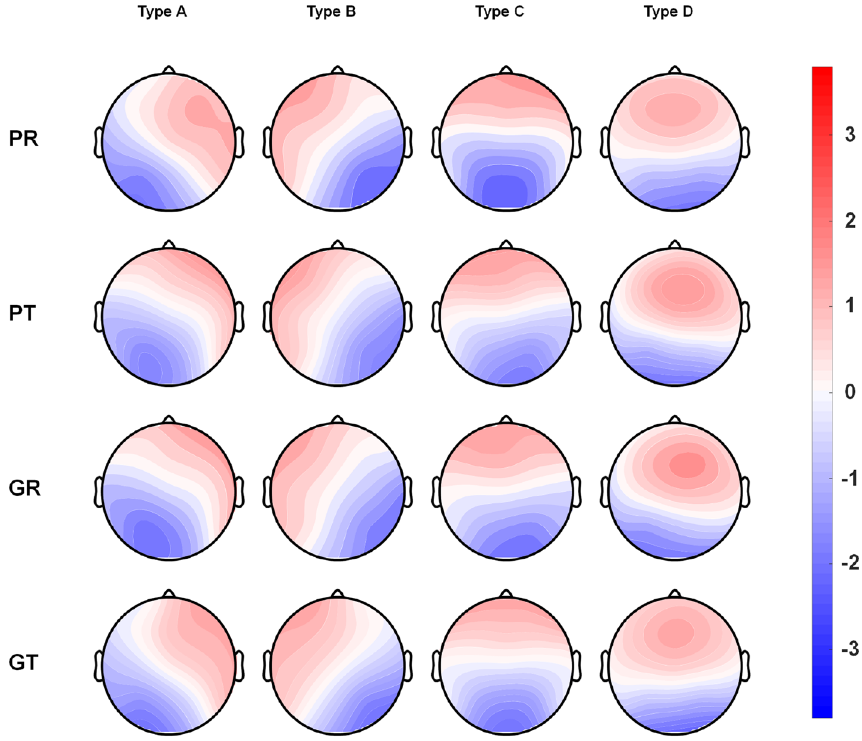
Figure 1. Four microstates of EEG recordings from resting and task states were obtained in good performers and poor performers. PR poor performers in the resting state, PT poor performers in task state, GR good performers in resting state, GT good performers in task